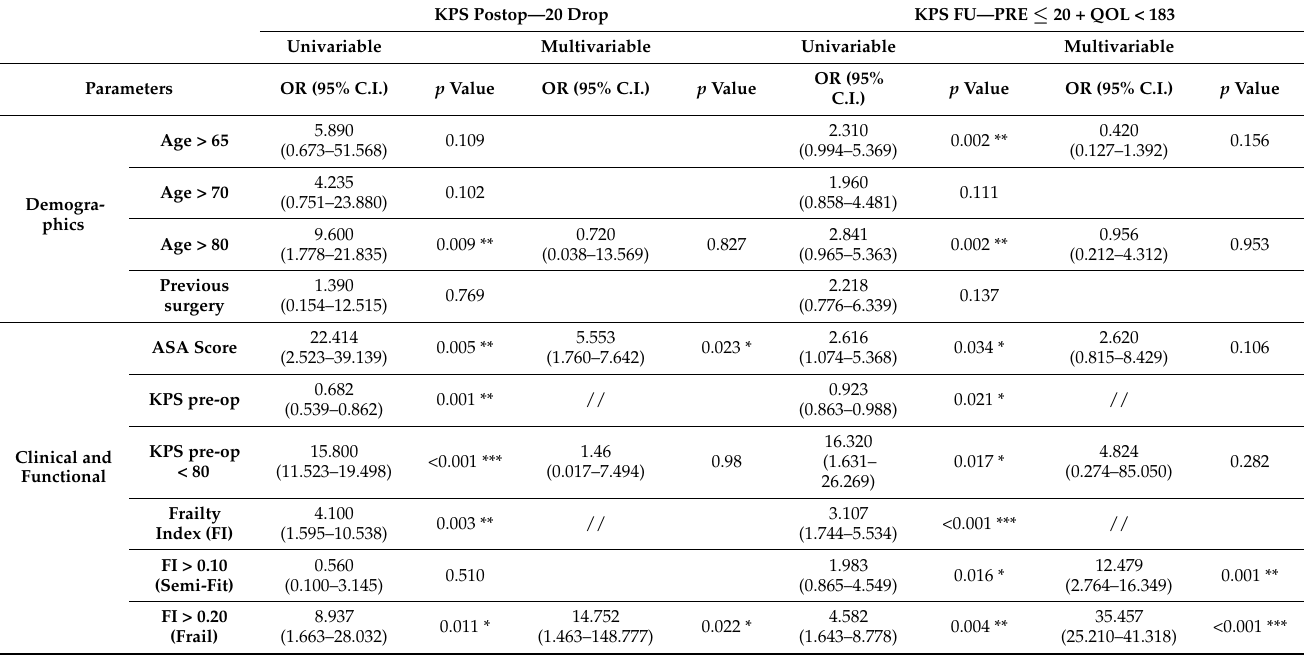
Table 3. Multivariable logistic regression